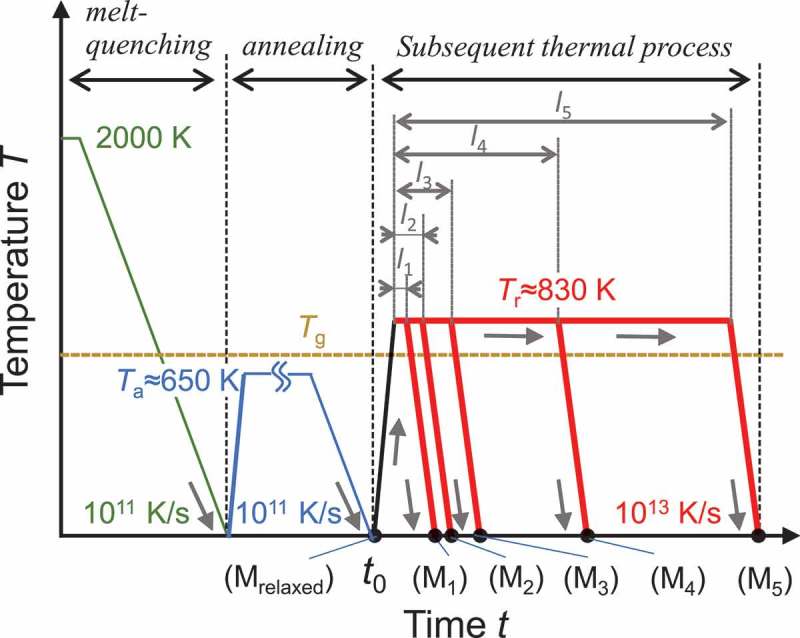
Schematics of melt-quenching, annealing, and subsequent thermal processes. M relaxed is the model after annealing. M 1, M 2, M 3, M 4, and M 5 are the models after the subsequent thermal process, in which the isothermal holding times are 0.5, 1.0, 2.0, 5.0, and 10.0 ns, respectively.